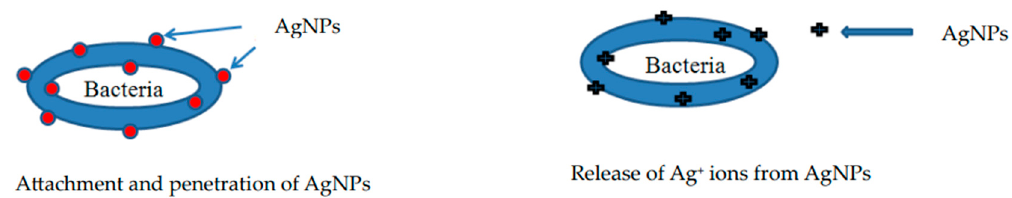
Figure 5. Mechanism of antibacterial action of AgNPs.